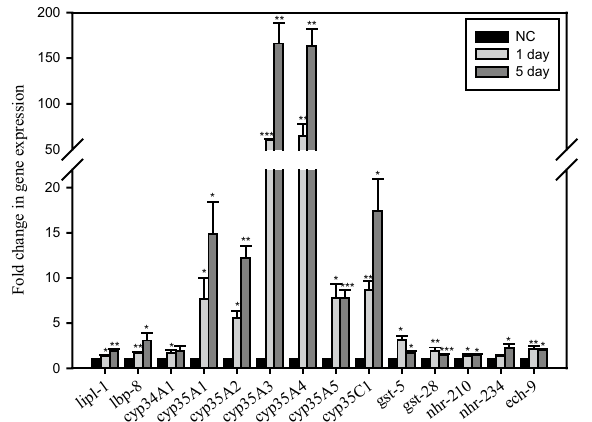
Figure 4. Expression levels of genes related to xenobiotic metabolism, lysosomes, and NHRs in remofuscin- treated C. elegans . Worms were grown on NGM plates containing 0 µM and 200 µM remofuscin for 1 and 5 days, and the gene expression levels were measured by qPCR. The experiments were independently conducted at least three times. * p < 0.05, ** p < 0.01, *** p < 0.001, Student’s t-test, compared with the NC (0 μM remofuscin) on each